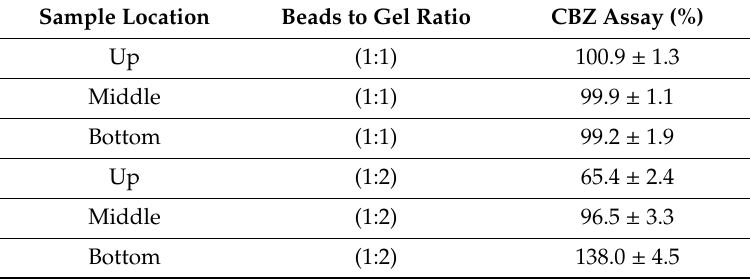
Table 1. Homogeneity of CBZ gel.